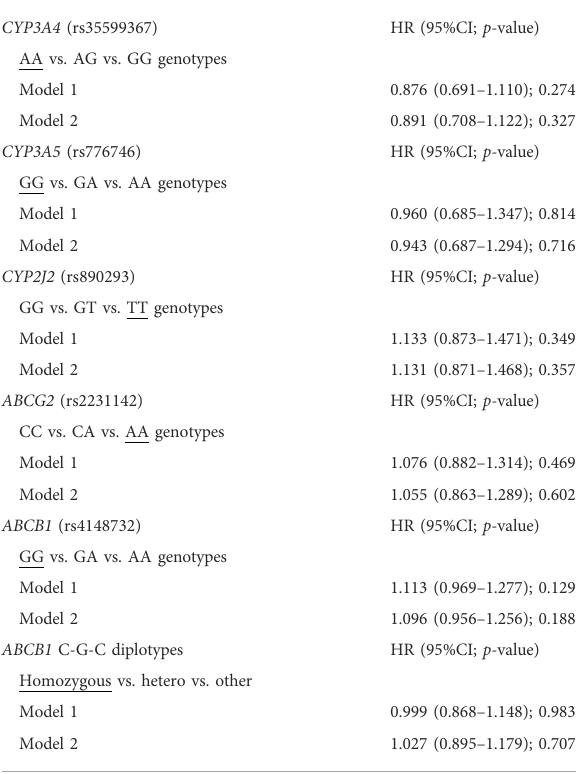
TABLE 4 Cox proportional hazards regression with time-varying analysis assessing the association of additive PK-related genetic variant models with DOACs bleeding